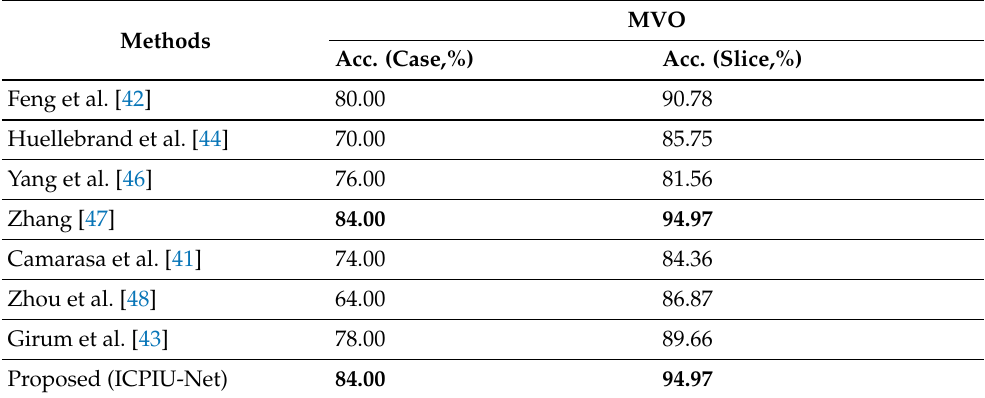
Table 6. Additional metrics for EMIDEC myocardial segmentation [62]. Best values are marked in bold font.